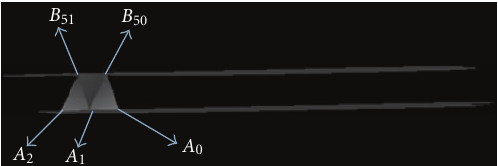
Figure 11: Triangle A 0 A 1 B 50 , triangle A 1 A 2 B 51 , and the triangle B 50 B 51 A 1 that forms between them.